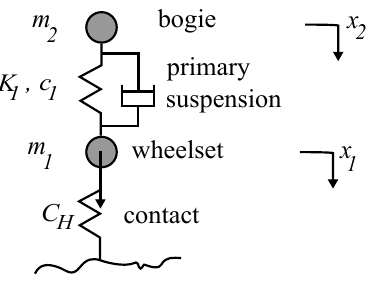
Figure 3. Quarter bogie